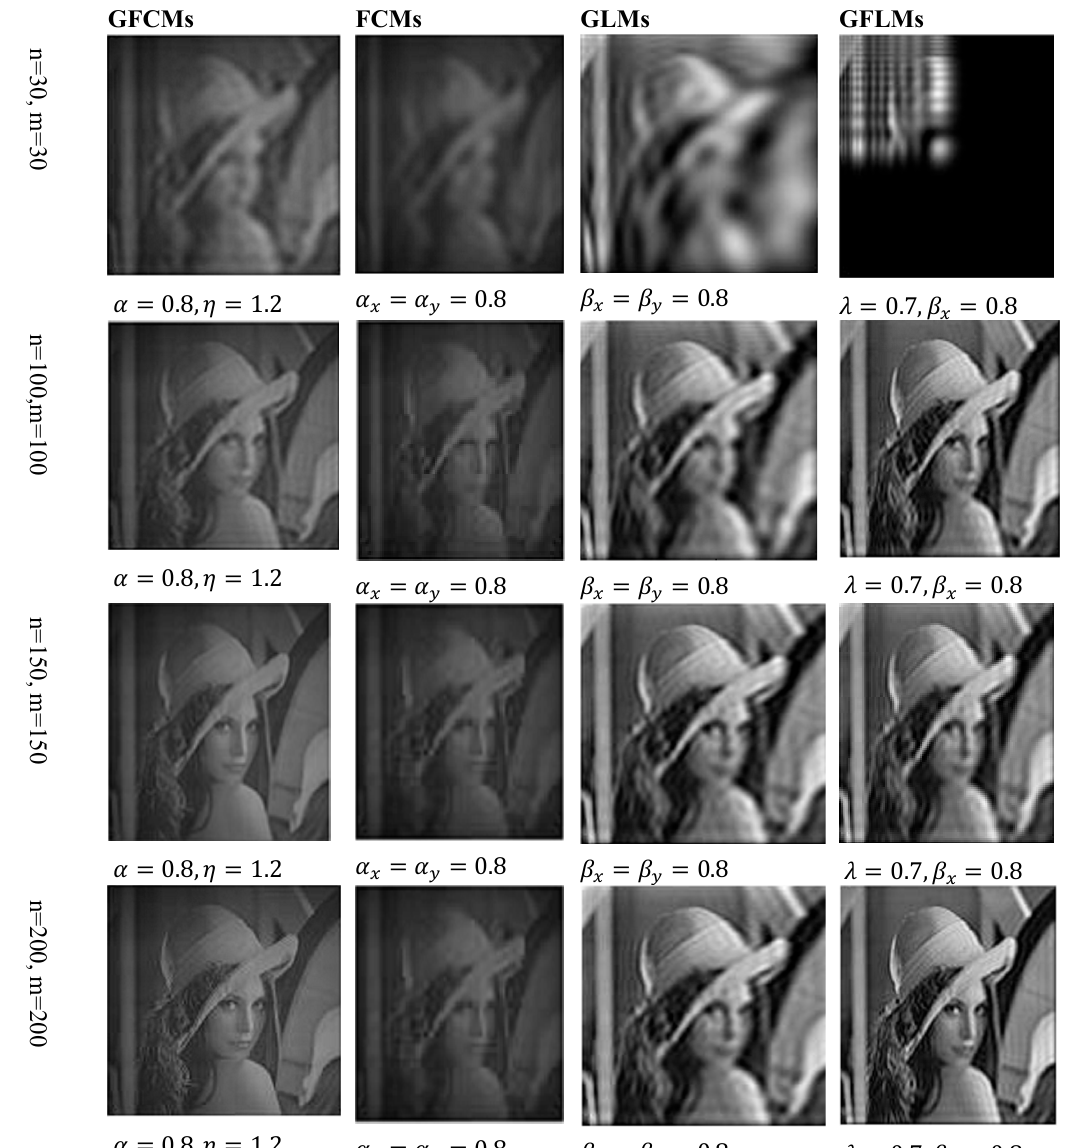
Figure 10. Shows the reconstructed Lena image at the same orders from the different proposed GFCMs, FCMs, Generalized Laguerre Moments (GLMs algorithm 3 and GFLMs).